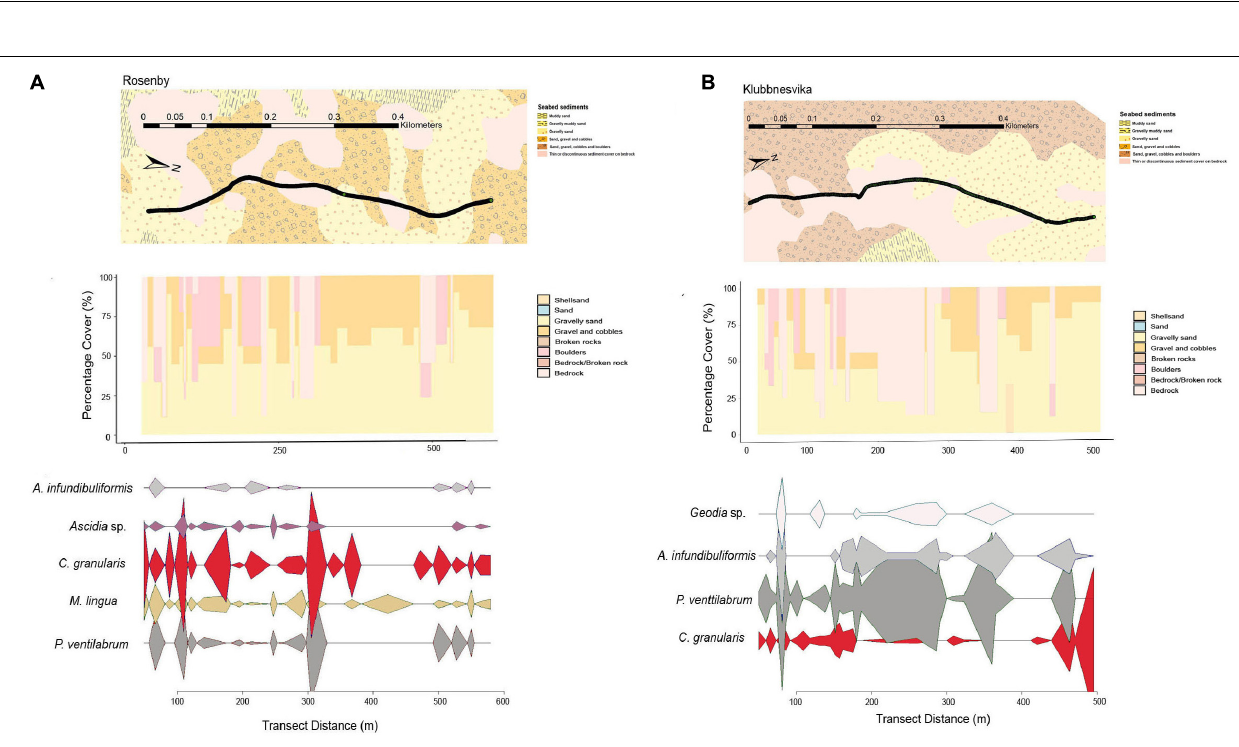
Frontiers in Marine Science |